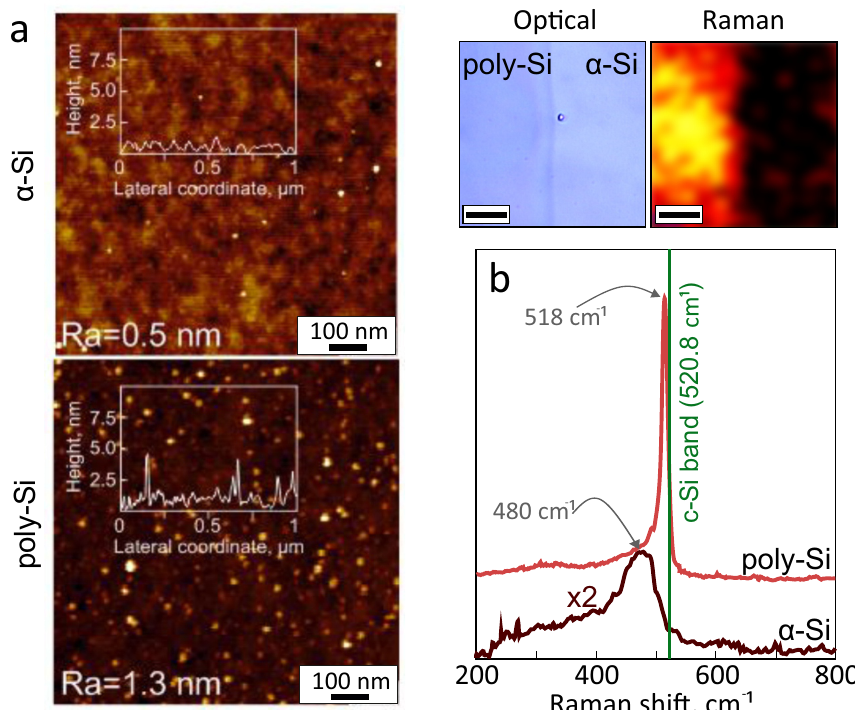
Figure 2. ( a ) AFM images revealing surface morphology and roughness of pristine α -Si and laser-annealed poly-Si films. ( b ) Raman spectra of pristine α -Si and laser-annealed poly-Si. Insets in ( b ) provide correlated contrasted optical and micro-Raman (@518 ± 3 cm − 1 ) images taken near the boundary between pristine and annealed poly-Si. Scale bar in both images indicates 7 µ